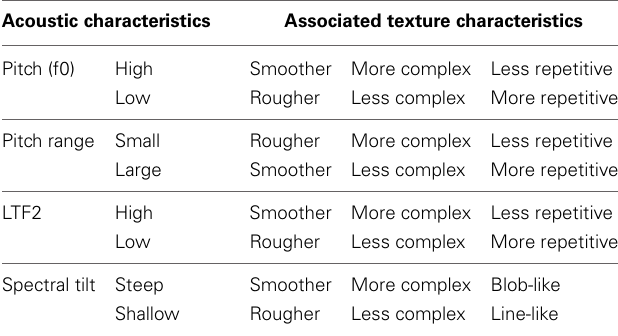
Table 7 | Summary of significant influences of acoustic characteristics of the voices on the associated textures.